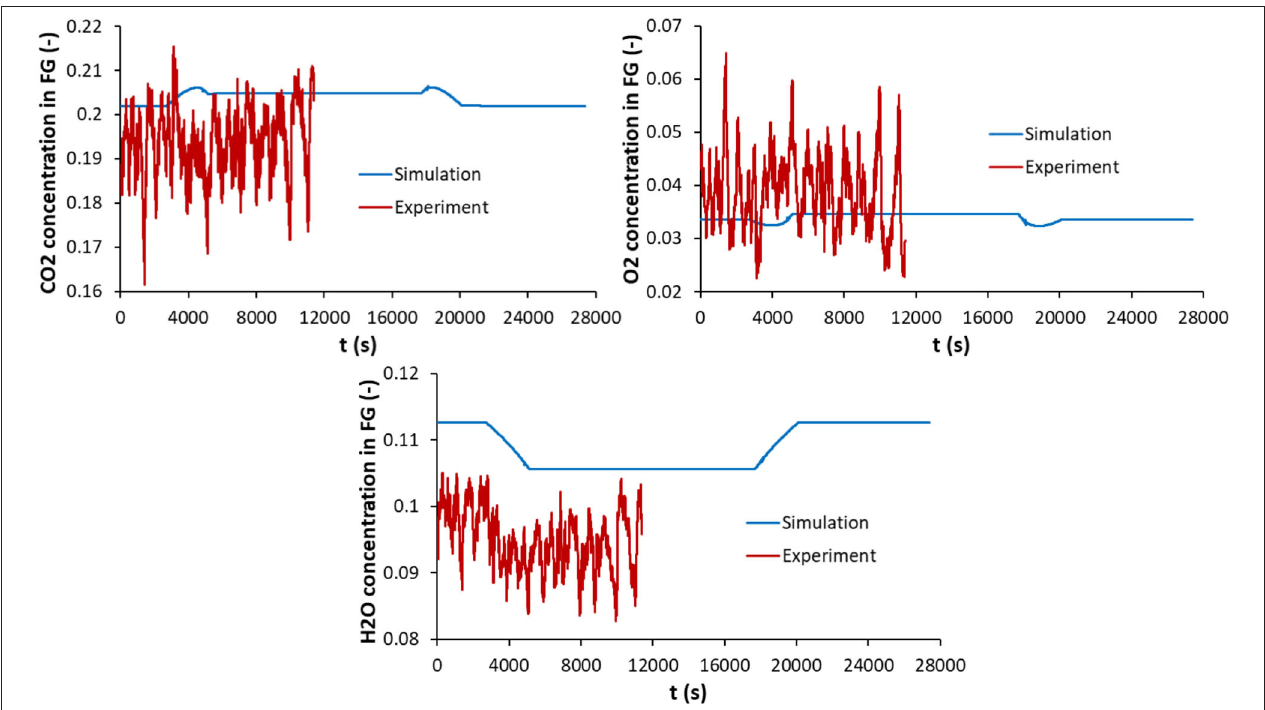
FIGURE 8 | Temporal evolution of flue gas components as predicted by the transient simulation ( H = 0.18m) and the experiment (0.11m).